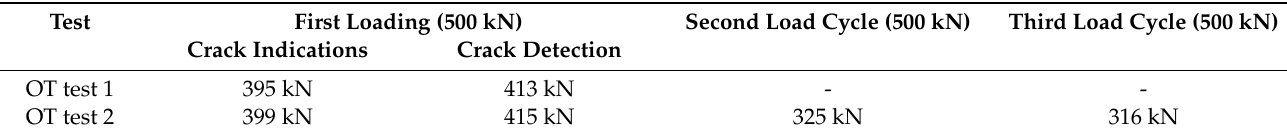
Table 2. Crack detection load levels.